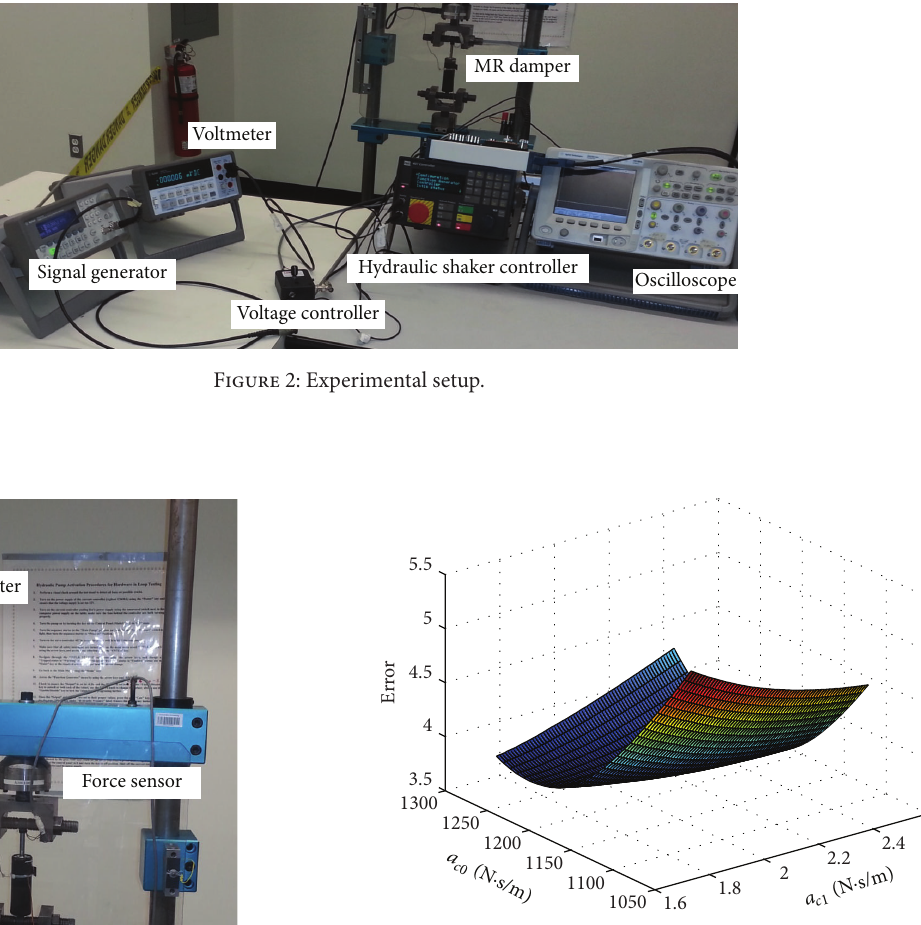
Figure 4: Sensitivity of objective function to variation of viscosity parameters of MR damper in 1.5